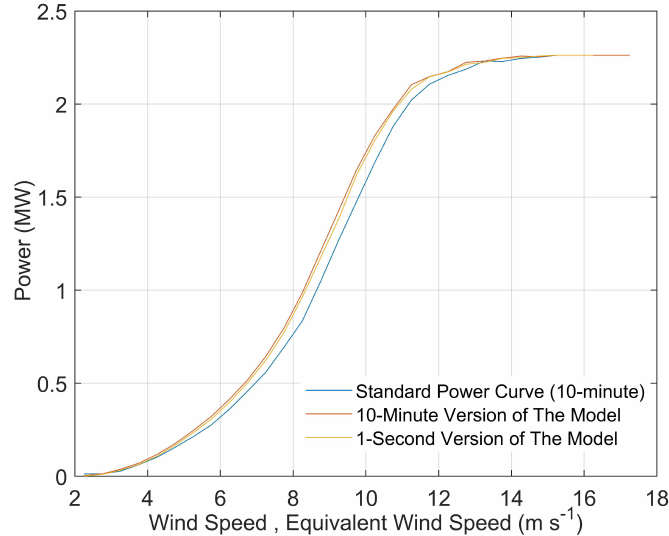
Figure 8. Standard power curve versus ten-minute and one-second versions of the model based